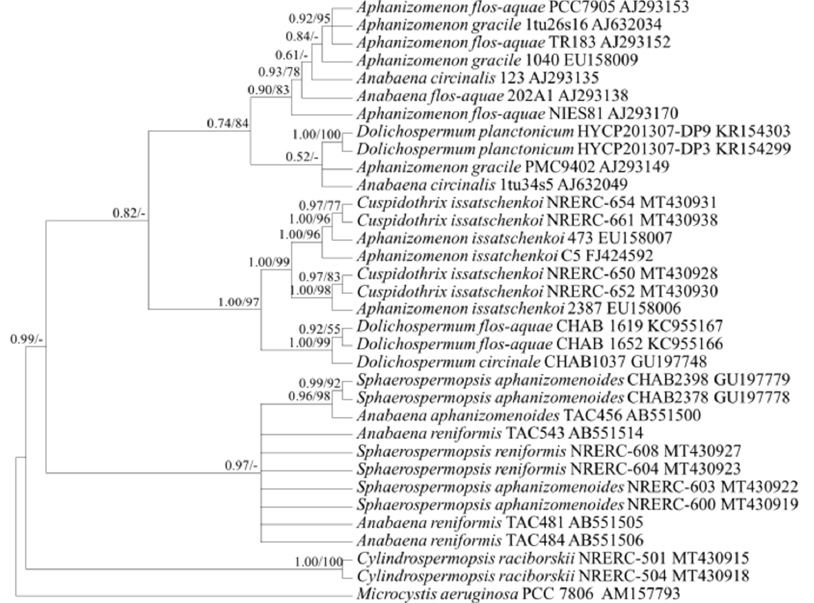
Figure 4. Consensus Bayesian tree based on aligned 993-bp sequences of rbcLX using the GTR+G+I model with Microcystis aeruginosa as an outgroup. The parameters were as follows: assumed equal nucleotide frequency; substitution rate matrix with A–C substitutions = 0.1028, A–G = 0.2947, A–T = 0.1220, C–G = 0.0857, C–T = 0.3330, and G–T = 0.0615; proportion of sites assumed to be invariable = 0.0155; and rates for variable sites assumed to follow a gamma distribution with the shape parameter = 0.9935. The branch lengths are proportional to the amount of character changes. The numbers above the branches indicate the Bayesian posterior probability ( left ) and maximum-likelihood bootstrap values ( right ). Posterior probabilities ≥ 0.5 are shown.